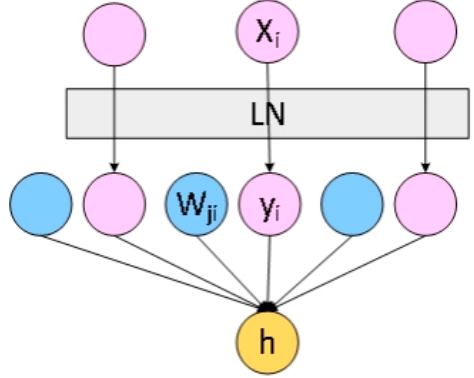
Figure 9. The structure of Layer Normalization.